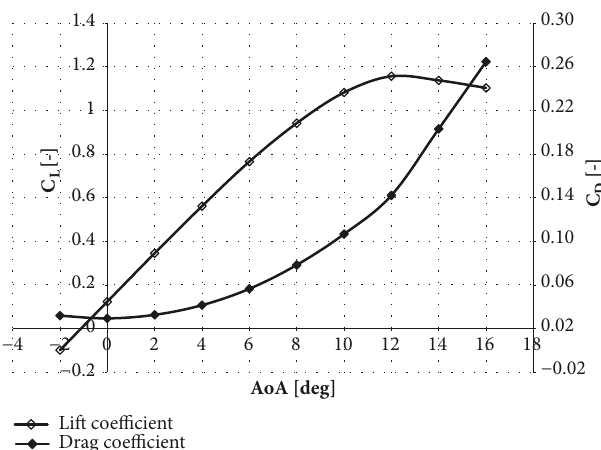
Figure 9: Lift and drag coefficients versus angle of attack (AoA) for the final UAV design (Re = 237 000).